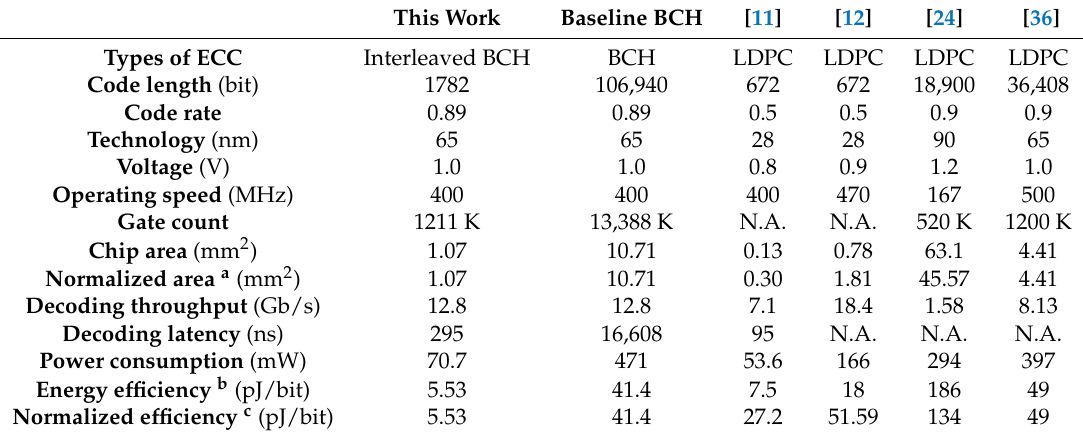
Figure 10. Error-correcting capabilities of different ECC solutions. Table 2. Comparison of ECC solutions for near-field wireless